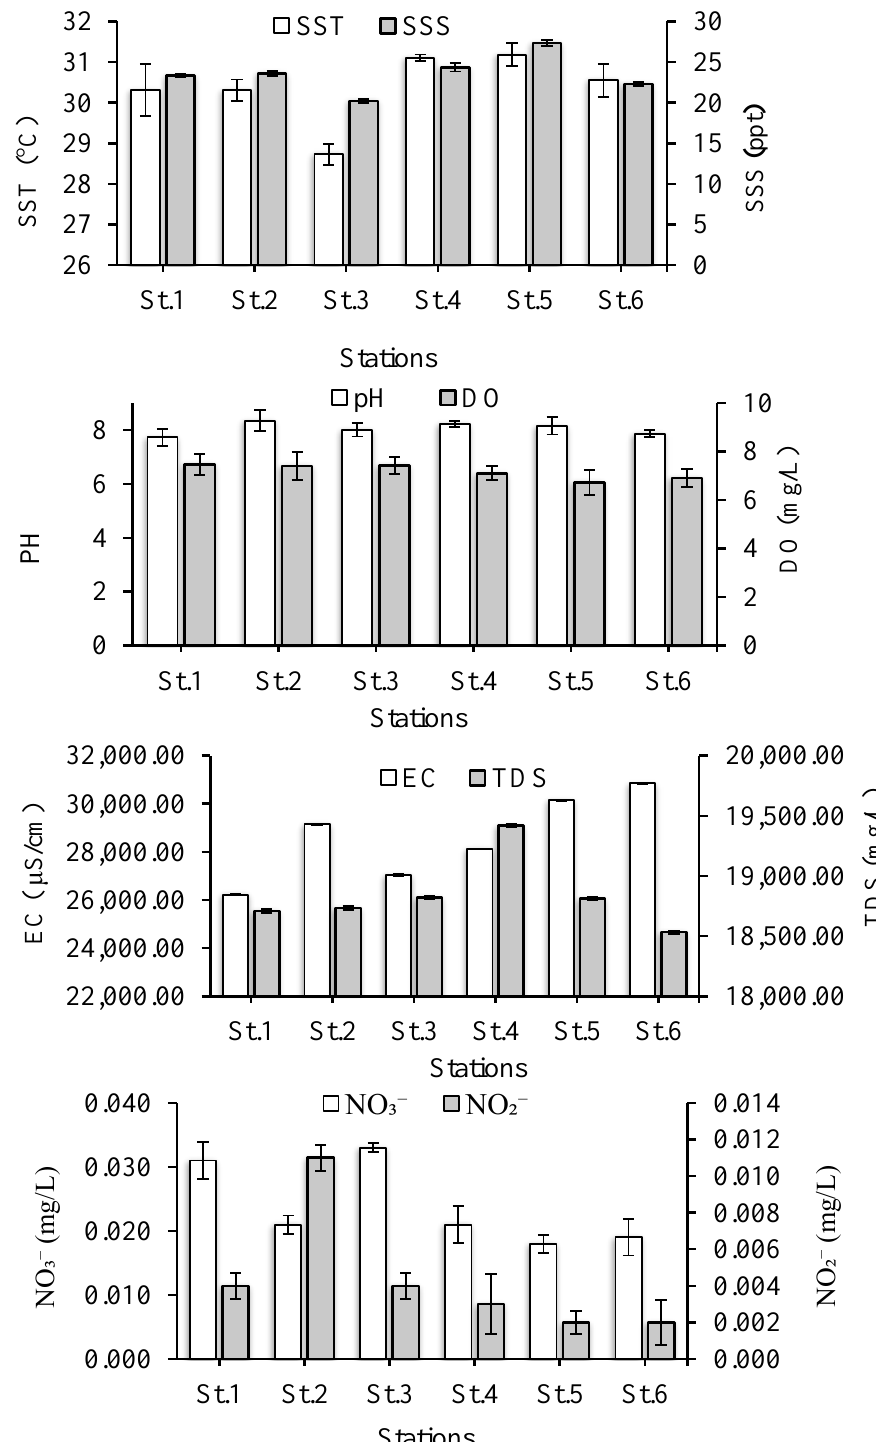
Figure 2. Variations in seawater parameters (mean ± SD) along the study area: seawater surface temperature (SST) and salinity (SSS); pH and dissolved oxygen (DO); electrical conductivity (EC) and total dissolve solid (TDS); and total suspended sediment (TSS) and organic matter (OM).